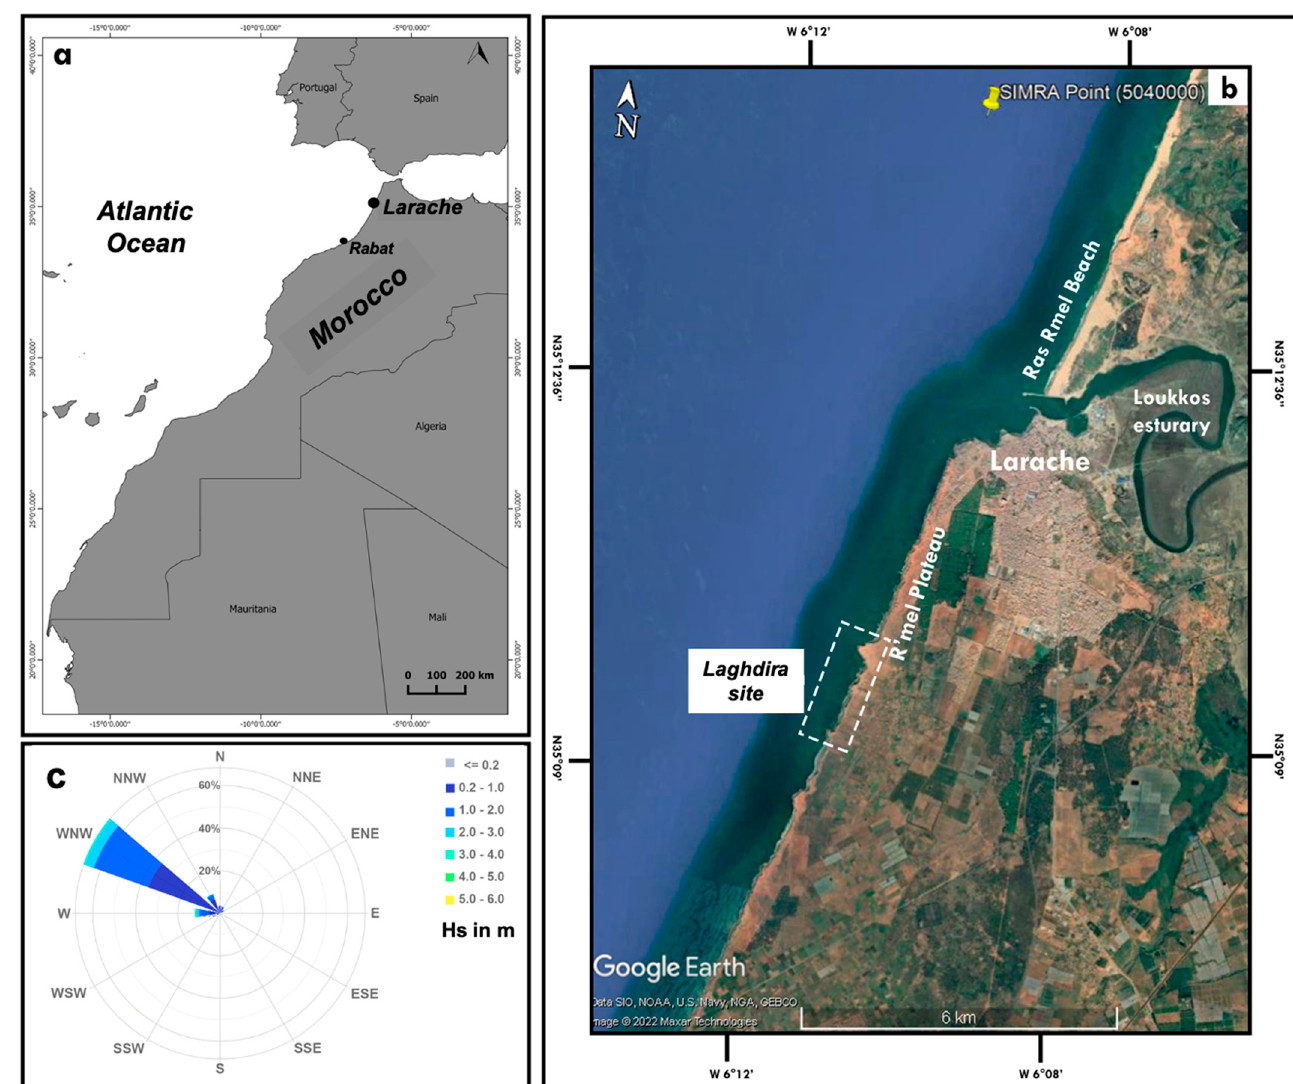
Figure 1. ( a ) Location of the study area; ( b ) Google Earth map of the Laghdira site with wave data source (SIMAR) location; ( c ) wave rose off the study area based on data from 2000 to 2020 for SIMAR spot 5040000.